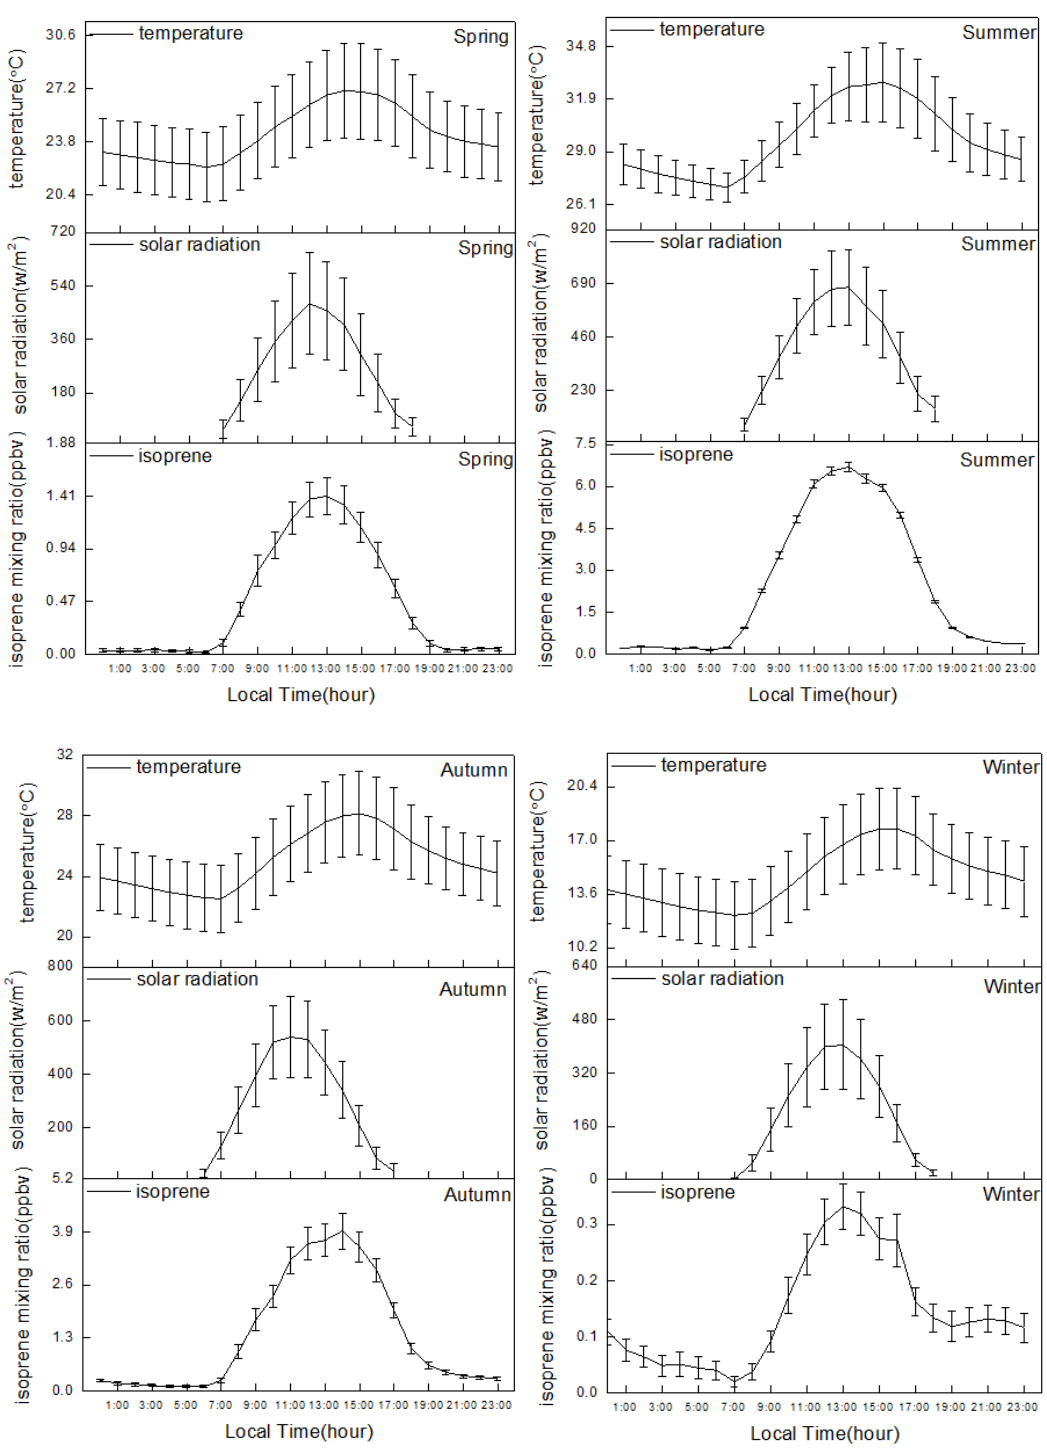
Figure 4. Diurnal variations of isoprene, solar radiation, and temperature in each season from June 2011 to May 2012 at